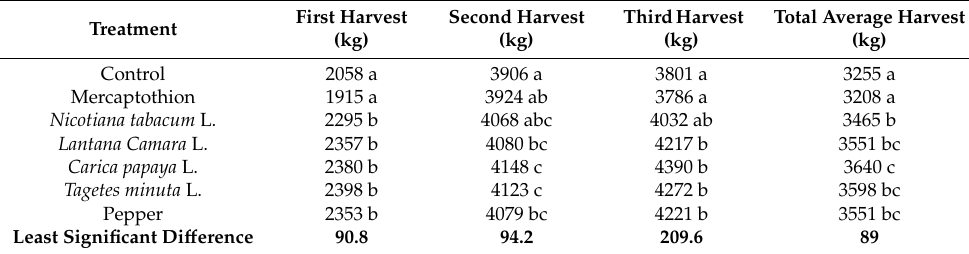
Table 6. Harvest of okra pod yield in kg / ha.